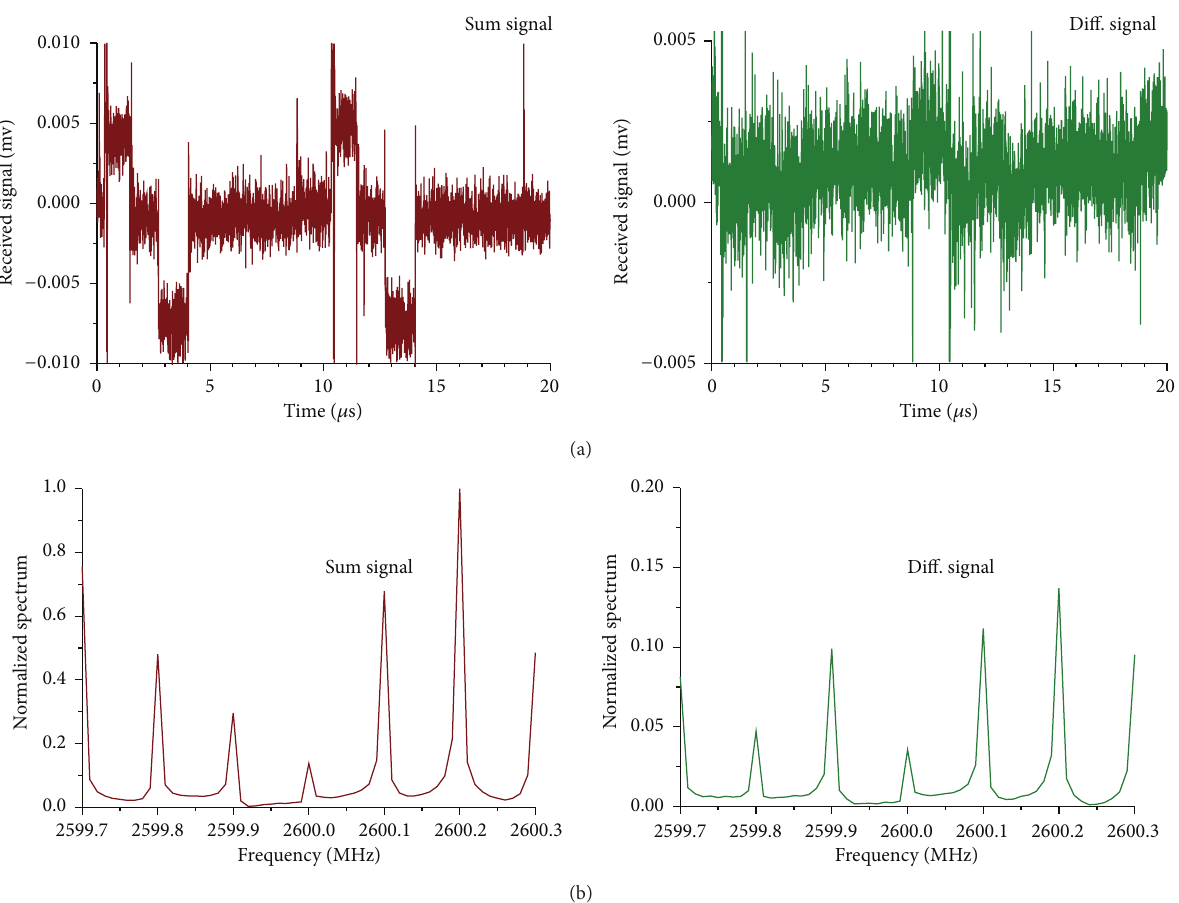
Figure 15: The procedure to obtain the difference-sum ratio 𝐾 : (a) waveforms of sum and difference signals at 𝜃 = 30 ∘ and (b) spectra of sum and difference signals at 𝜃 = 30 ∘ .